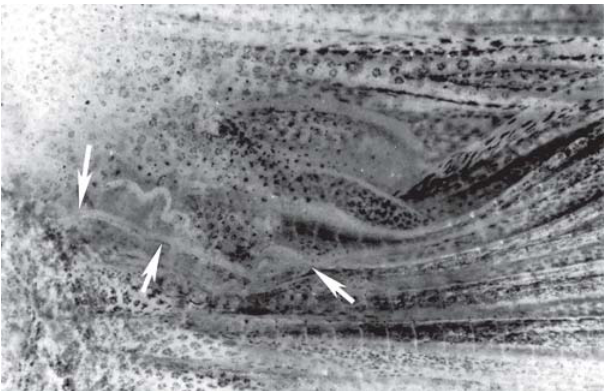
Fig. 72. Mimagoniates rheocharis , adult male, USNM 279879, 49.0 mm SL; central basal region of caudal-fin and adjacent caudal peduncle, lateral view, left side, anterior at left. Arrow at left indicates anterior intake region of pump chamber; middle arrow indicates region of lateral slit with ray half of principal caudal ray 11 just dorsal to arrow tip; arrow at right points to opening of posterior exhaust vent of pump chamber. Modified from Menezes & Weitzman